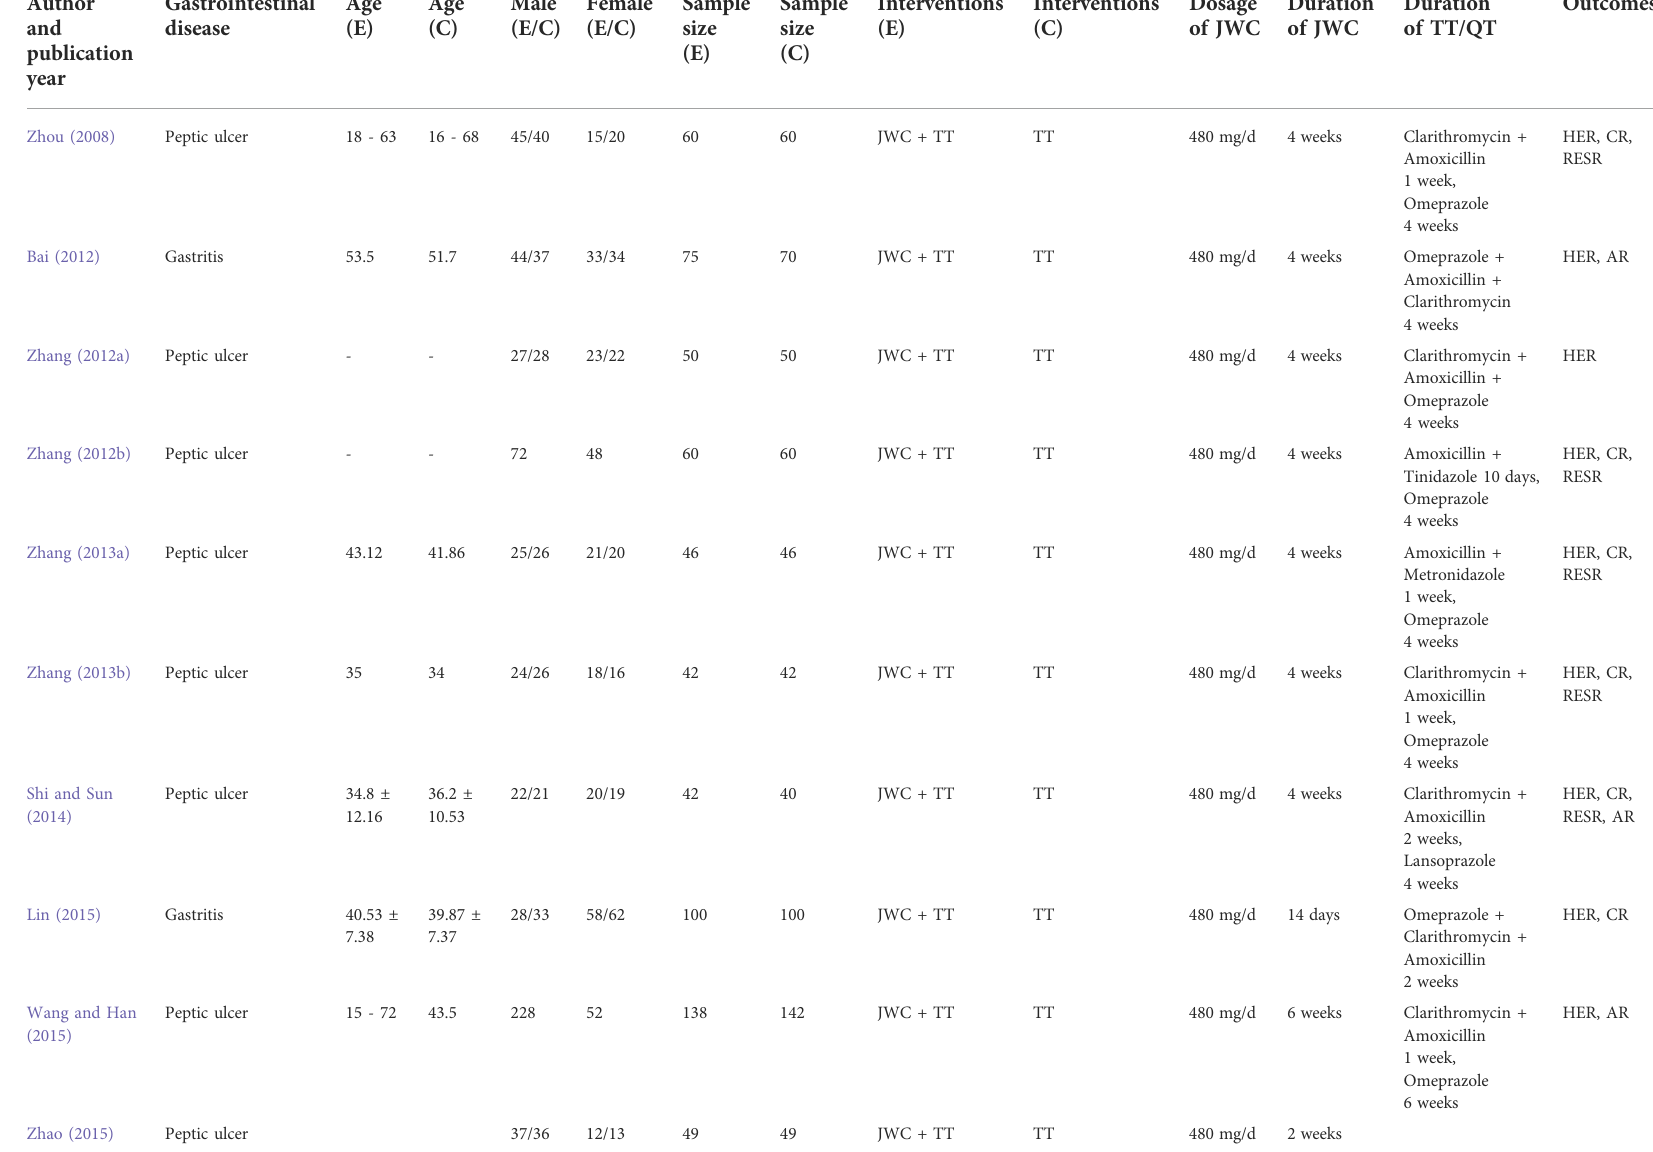
TABLE 2 Characteristics of included